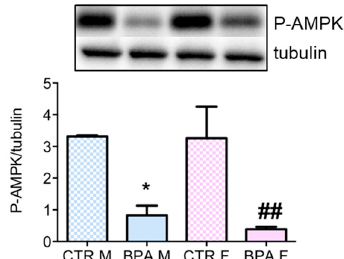
Figure 4. AMPK phosphorylation in the brain of rat fetuses in utero exposed to 2.5 µg/kg/day of BPA. Representative western blot and densitometric analysis of P-AMPK. Tubulin served as housekeeping protein to normalize protein loading. n = 6 for each experimental group. Statistical analysis was carried out by using two-way ANOVA followed by Bonferroni post-hoc test. * = p < 0.05 vs. CTR M; ## = p < 0.01 vs. CTR F.